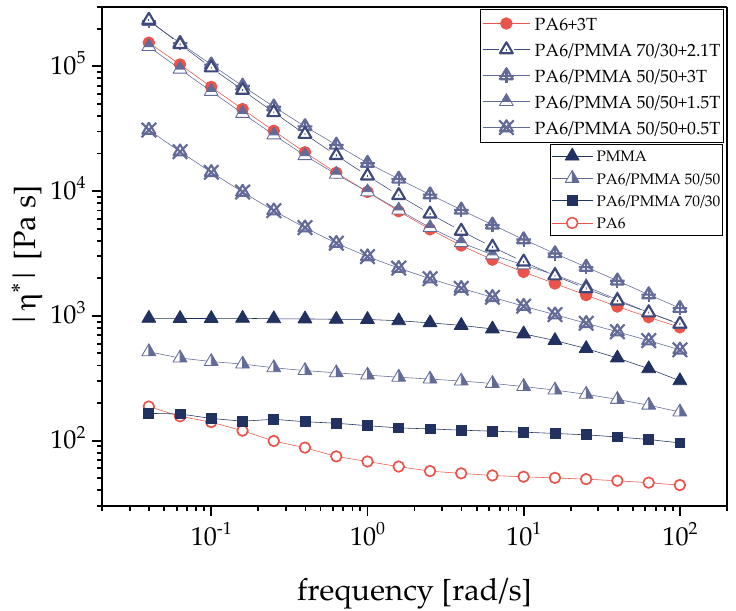
Figure 4. Complex melt viscosity | η *| of PA6, PMMA and PA6/PMMA blends without and with different amounts of SWCNT filler Tuball (T).